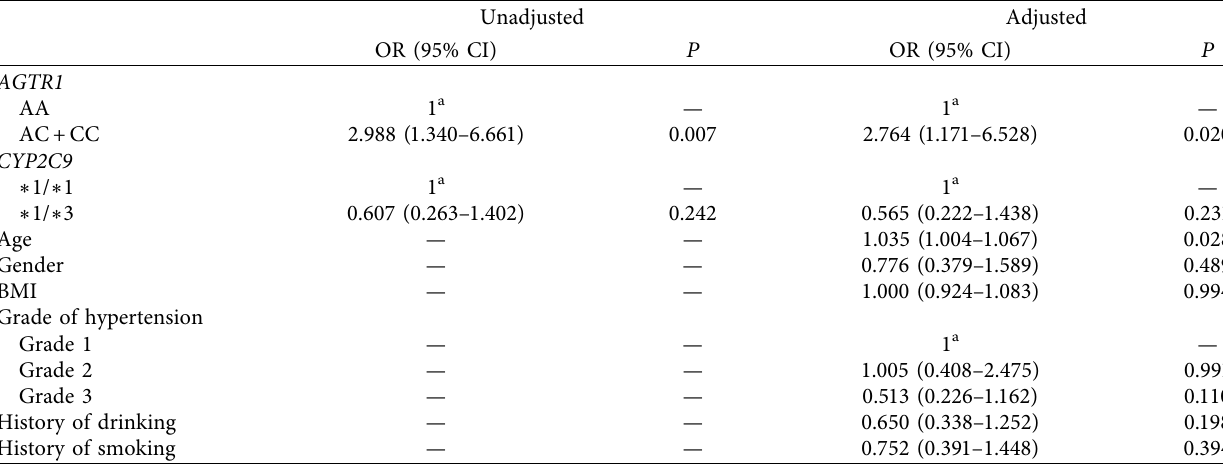
Table 3: Associations of gene polymorphisms and good response to valsartan treatment in the univariate and multivariate analyses. Unadjusted Adjusted